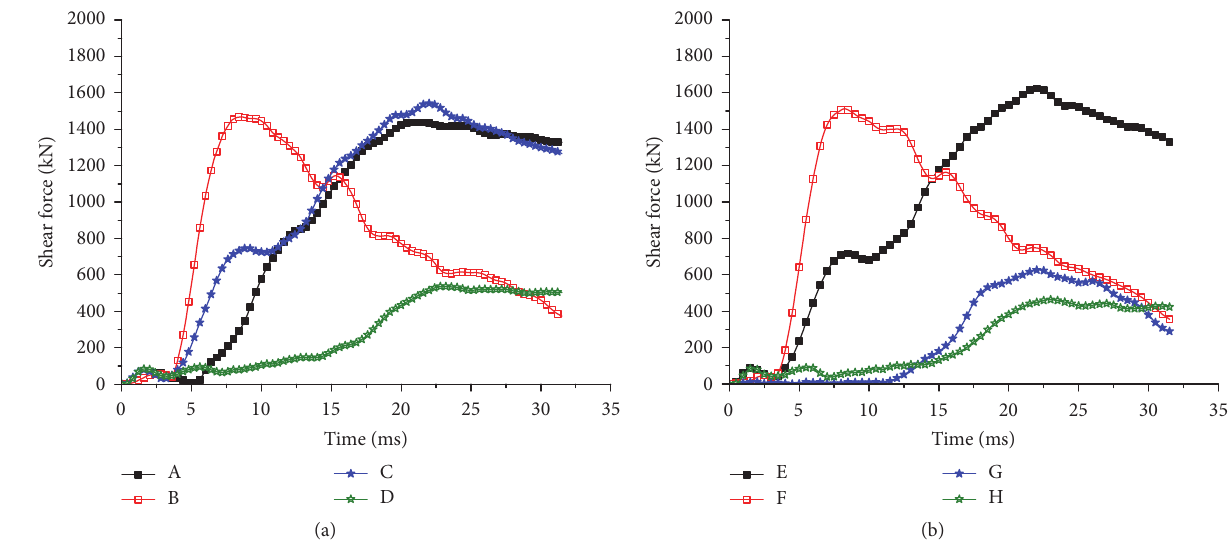
Figure 16: The tensile force time history curves for (a) bolts A, B, C, and D and (b) bolts E, F, G, and H in Model